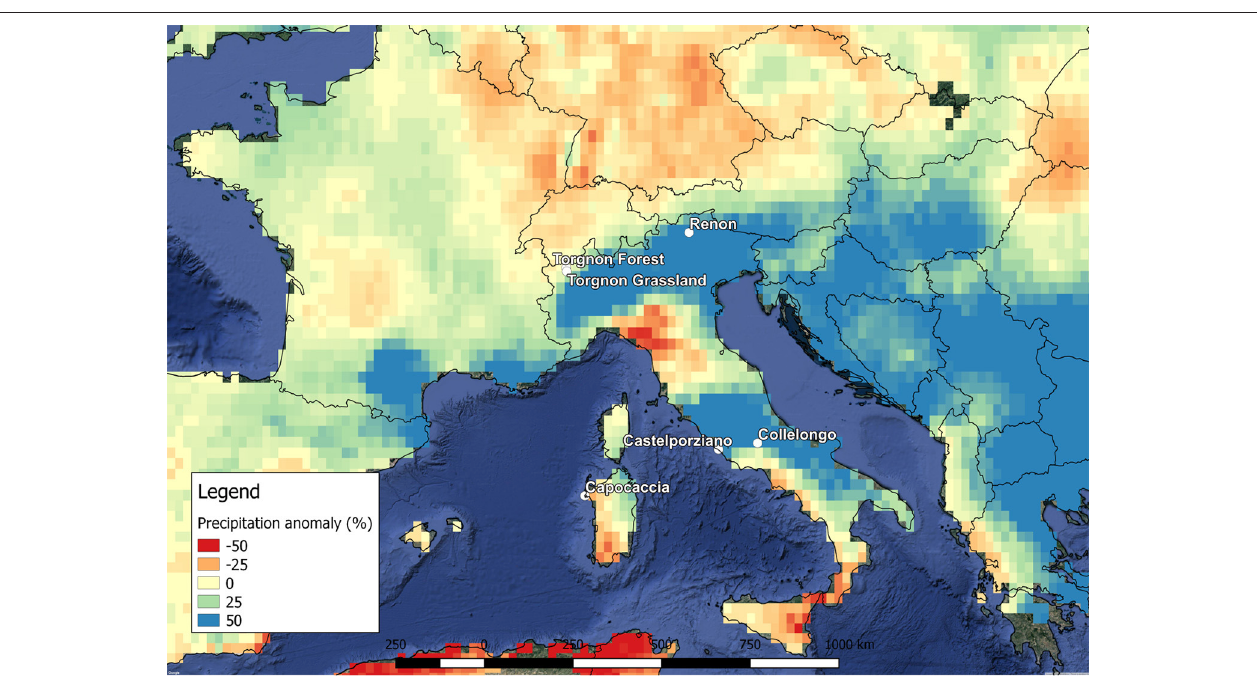
FIGURE 1 | Annual precipitation anomaly (%) observed in 2014 compared with the climatic average 1981–2010 method used for analysis of anomalies by Haylock et al. (2008). The six experimental sites in Italy are reported in the